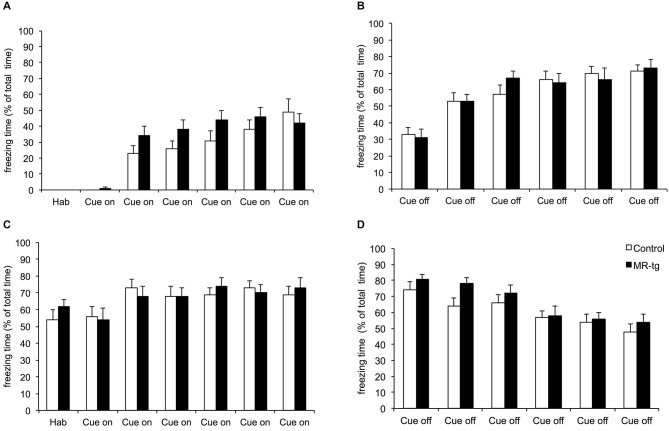
Effects of MR overexpression on combined cue and context conditioning. On the acquisition (day 1), animals were exposed to six tones followed by a foot shock. (A) Freezing behavior was scored during the tone (cue on) and after the tone (cue off) (B). Forty-eight hours later mice were exposed to the same procedure as on day 1, but without shocks. Freezing behavior was scored during the tone (cue on) (C) and after the tone (cue off) (D). No group differences were observed. n = 15–18 mice per group.